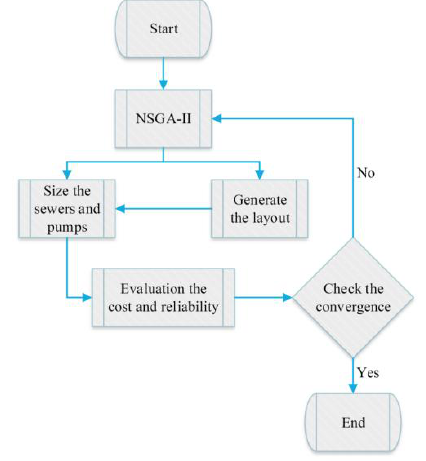
Figure 1. The multiobjective optimization framework for sewer networks